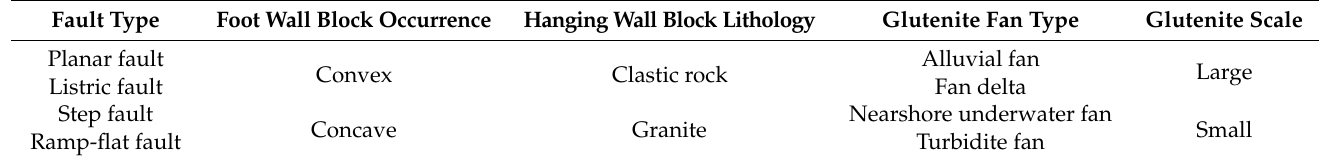
Table 1. Fault and glutenite characteristics.